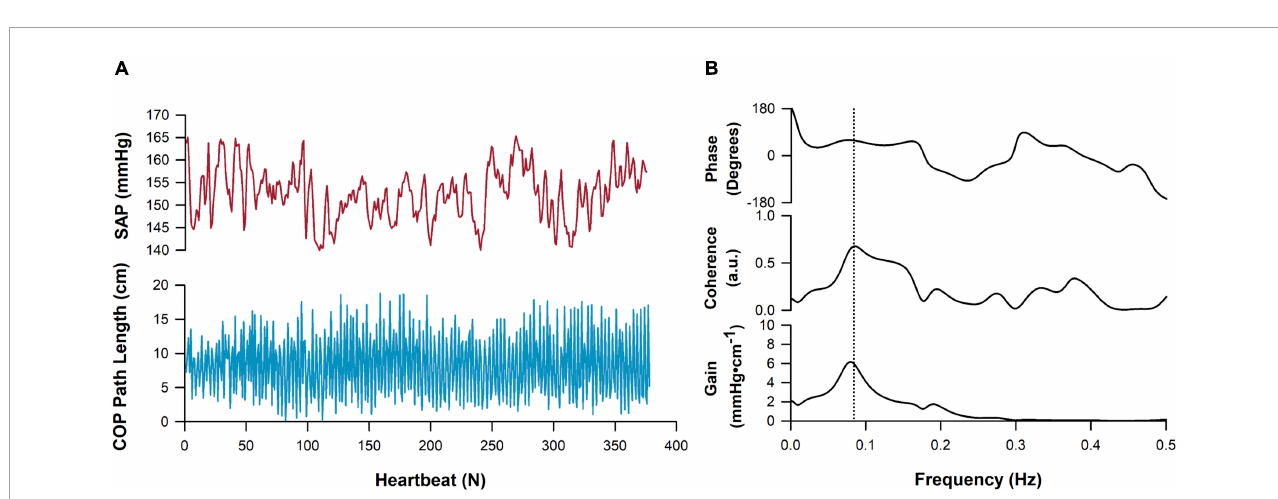
FIGURE6 Representative tracing of cross-spectral analysis. Cardio-postural data collected in the mediolateral direction are shown. (A) A timeseries of systolic arterial pressure (SAP, red) and postural sway movement, measured as center of pressure (COP) path length (blue) across approximately 350 heartbeats. (B) Cross-spectral analysis showcasing the frequency-domain relationship between SAP and postural sway time series. Peak coherence in this participant is denoted by the vertical dashed line and was detected at approximately 0.08